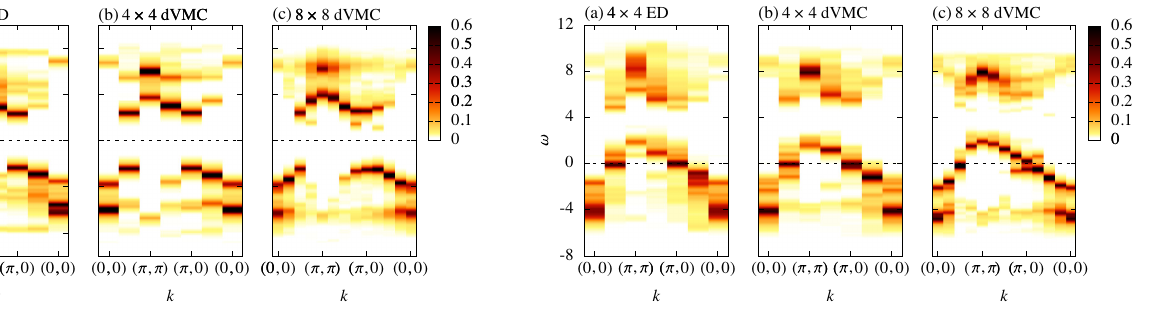
FIG. 6. Spectral weight for the doped square-lattice Hubbard 14 ) in panel (b) compared with the model ( N ¼ 4 × 4 and N e ¼ 56 ED result in panel (a). The result of the 8 × 8 lattice with N e ¼ at 12.5% hole doping is shown in panel (c). The momentum dependence is shown along the symmetric line in the same way as in Fig. 5. Here, ω ¼ 0 is the Fermi